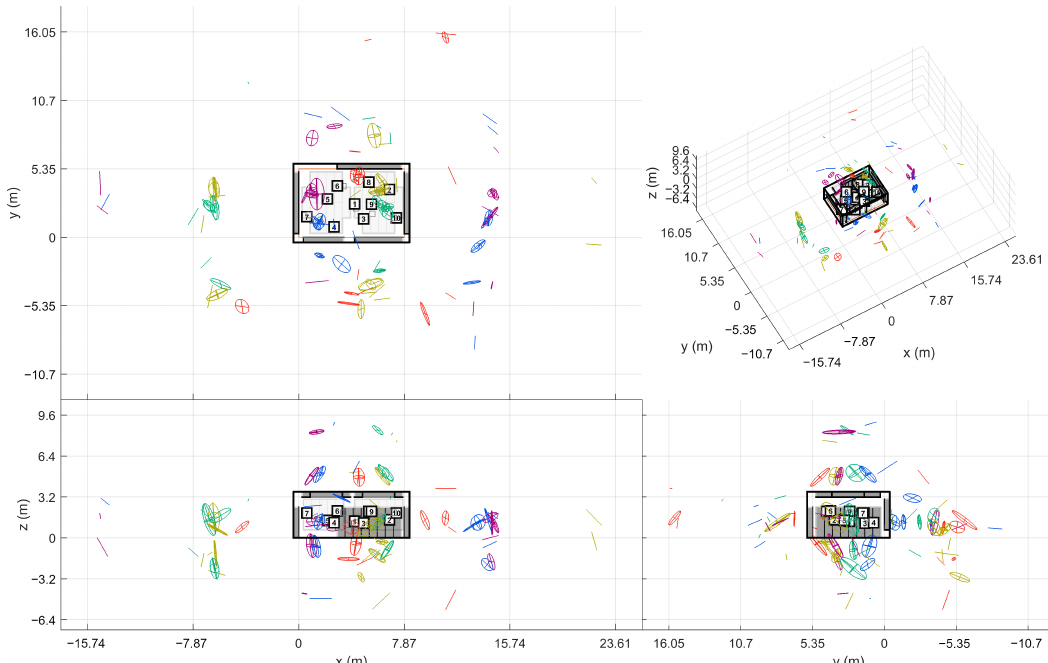
Figure A3. Found image sources for five loudspeaker positions in variable acoustics room Arni (min. 2 ER objects per image source). Lowering the number of required ER objects makes the algorithm find more higher-order image sources, but also increases the amount of noise.